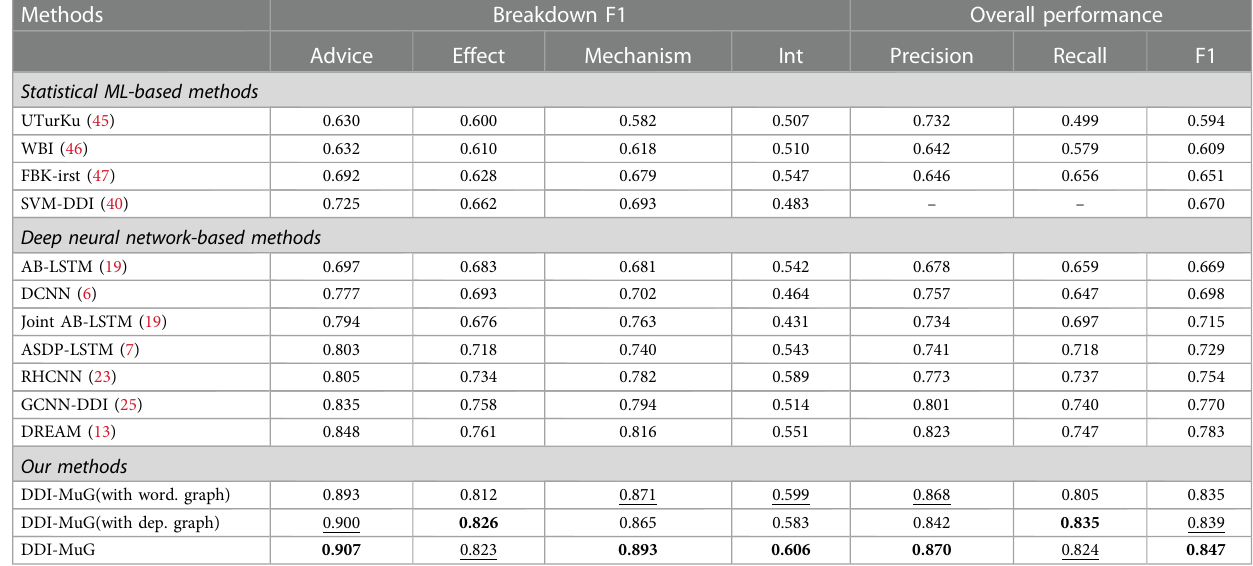
TABLE 3 Performance comparisons on DDIExtraction-2013 Corpus. The highest value is labelled in bold, and the second highest value is marked underline.